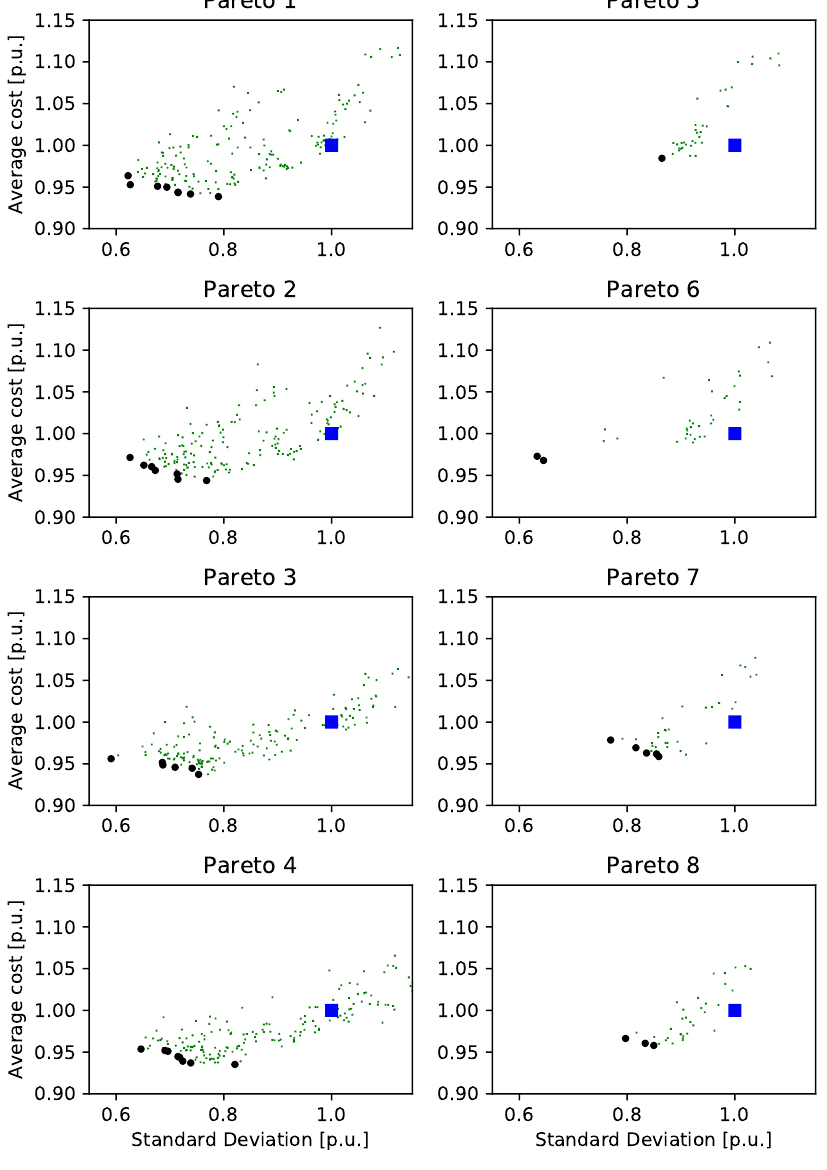
Figure 9. Performance points (green dots) and Pareto fronts ( • ) for each Alternative 1–8. Deterministic solution in blue